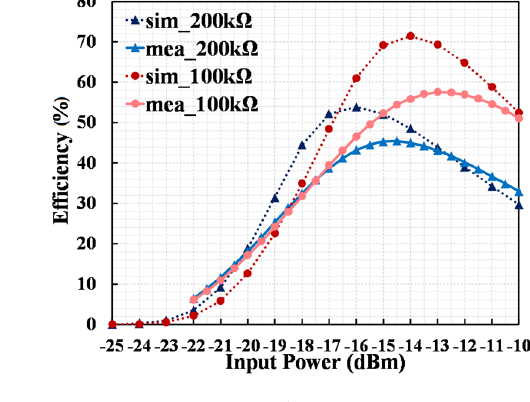
Figure 17. Measurement results of the rectifier, ( a ) output voltage versus input power for 𝑅 (cid:3013) = 100 k Ω and 200 k Ω ; ( b ) efficiency versus input power for 𝑅 (cid:3013) = 100 k Ω and 200 k Ω .